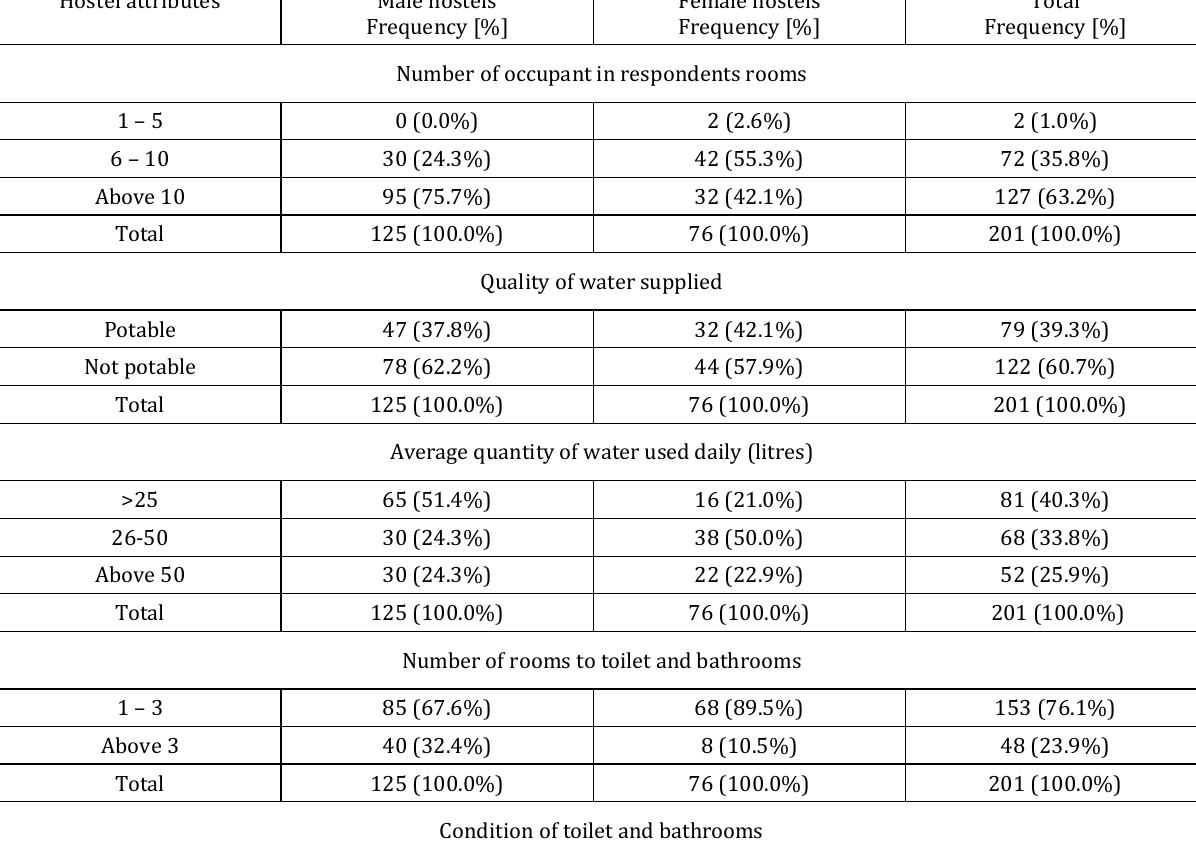
Table 3. Students’ living condition and access to environmental